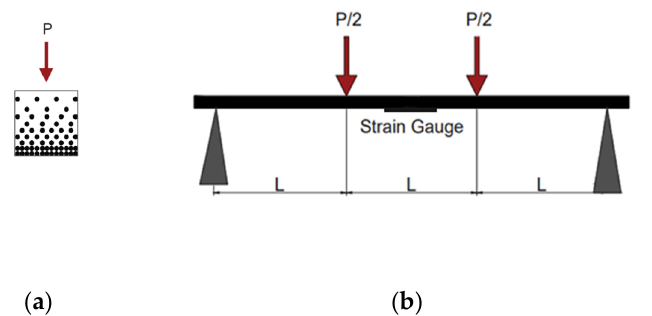
Figure 5. Bending test set-up. ( a ) Cross section of the specimen with the external side of the bamboo culm wall posed in the lower part (tension). ( b ) Four-point bending scheme.